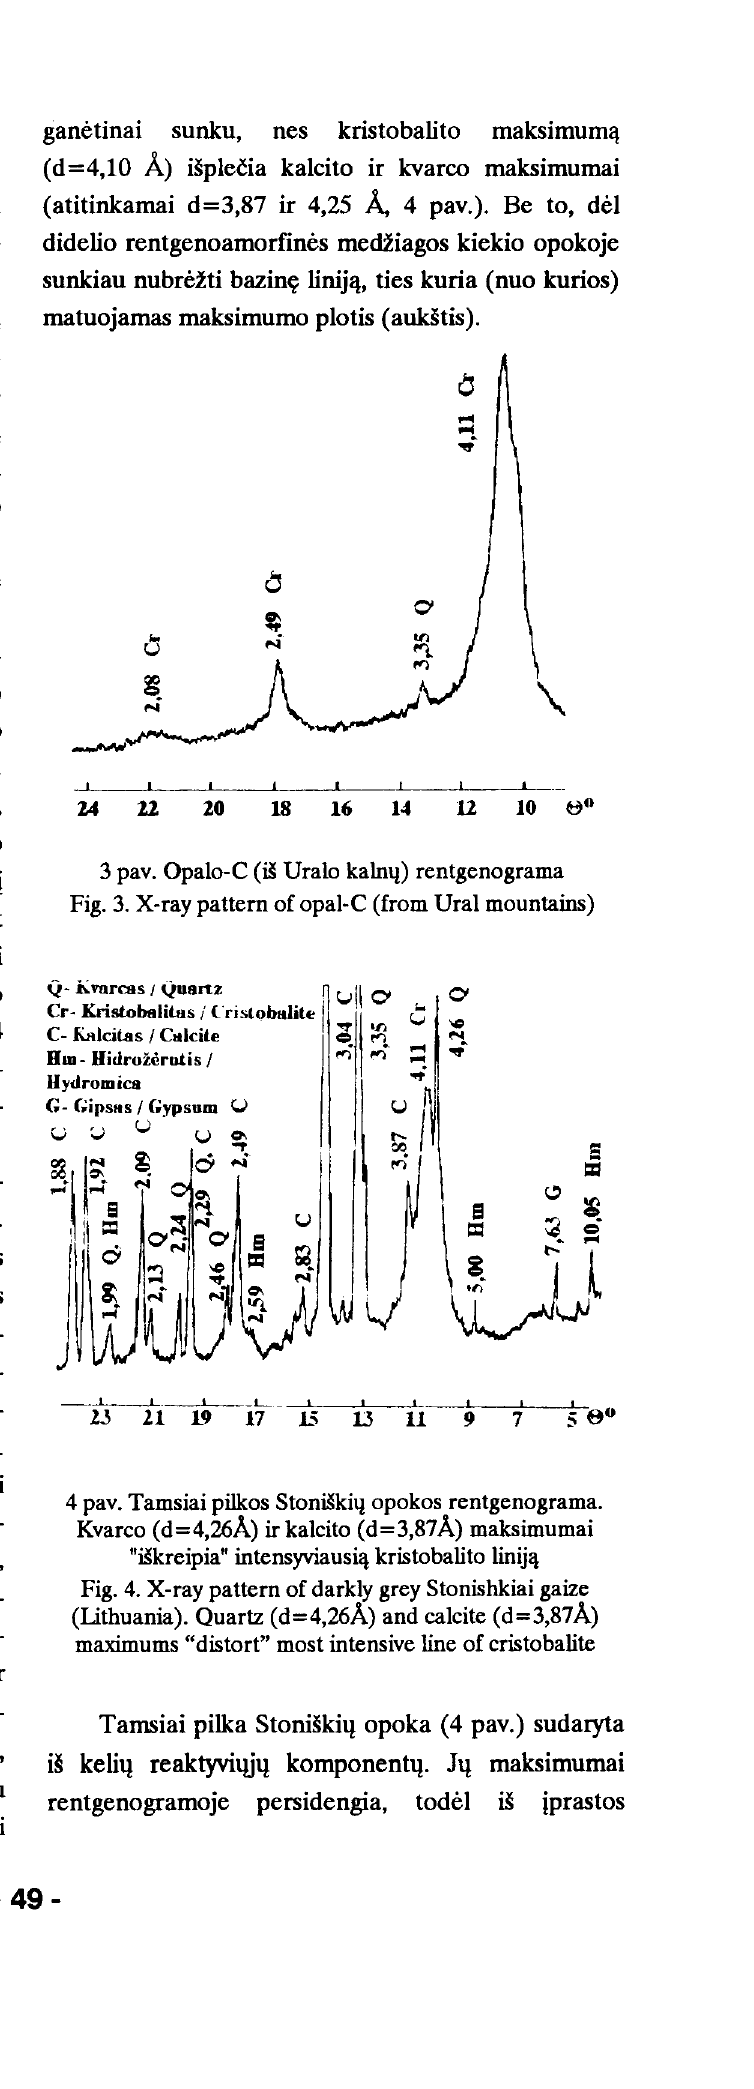
Fig. 4. X-ray pattern of darkly grey Stonishkiai gaize (lithuania). Quartz (d=4,26A) and calcite (d=3,87A) maximums "distort" most intensive line of cristobalite Tamsiai pilka Stoniskiq opoka (4 pav.) sudaryta i§ keliq reaktyviqjq komponentq. Jq maksimumai